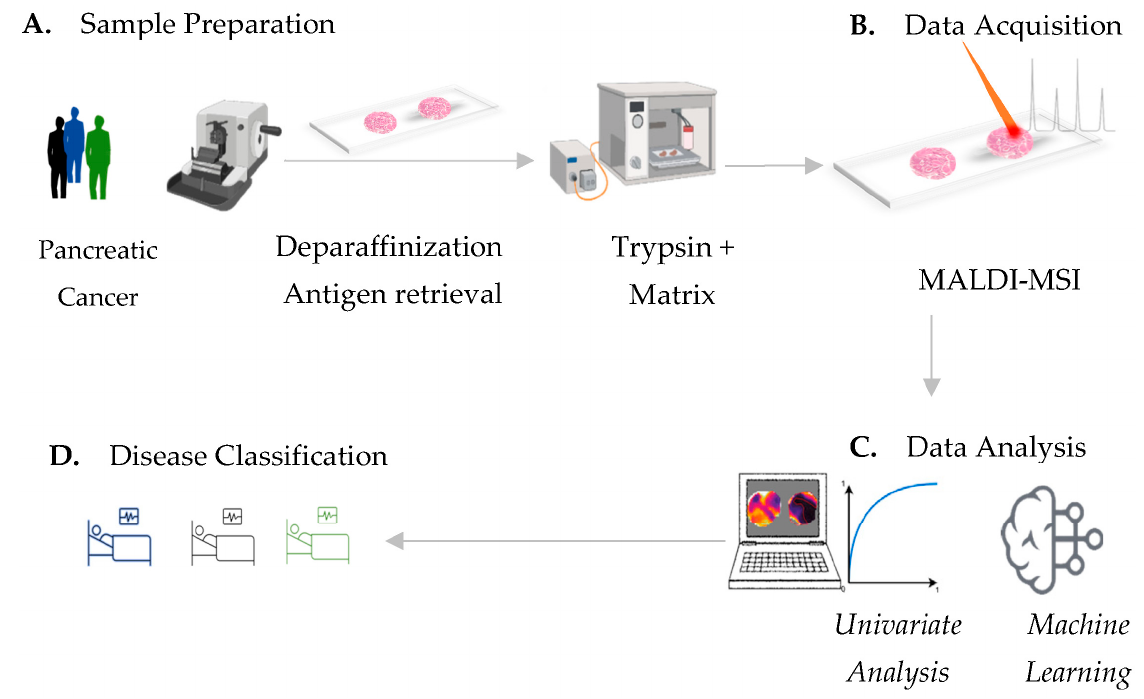
Figure 1. MALDI-MSI workflow for pancreatic-cancer-tissue assessment. ( A ) Pancreatic-cancer-tissue sample preparation includes deparaffinization, antigen retrieval followed by tryptic digestion and matrix application. ( B ) In situ determination of spatial mass to charge ( m/z ) signatures by means of MALDI mass spectrometry imaging. ( C ) Univariate testing of MALDI-MSI-derived data provides single discriminative m/z values, which can potentially identify distinct tissue types. Machine learning by neural-network strategies provides ( D ) an accurate classification of pancreatic-cancer types, which is potentially sufficient for clinical routine.